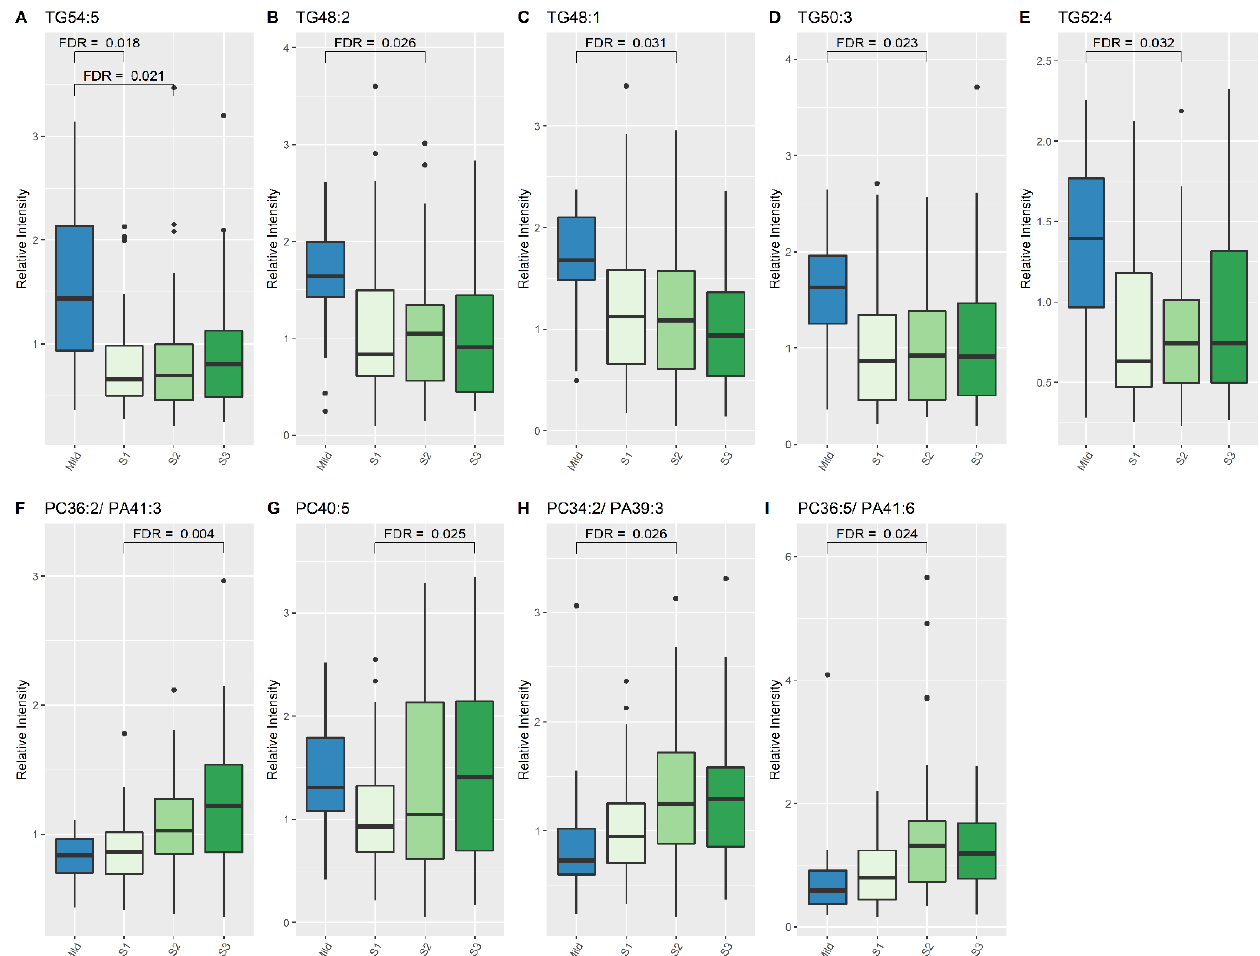
Figure 1. Lipid species from TG and PC classes which show significant differences between Mild HIE Cases and Moderate– severe HIE Cases at different time points (S1, S2 and S3). ( A ), TG54:5; ( B ), TG48:2; ( C ), TG48:1; ( D ), TG50:3; ( E ), TG52:4; ( F ), PC 36:2/PA41:3; ( G ), PC40:5; ( H ), PC 34:2/PA39:3; ( I ), PC 36:5/PA41:6.